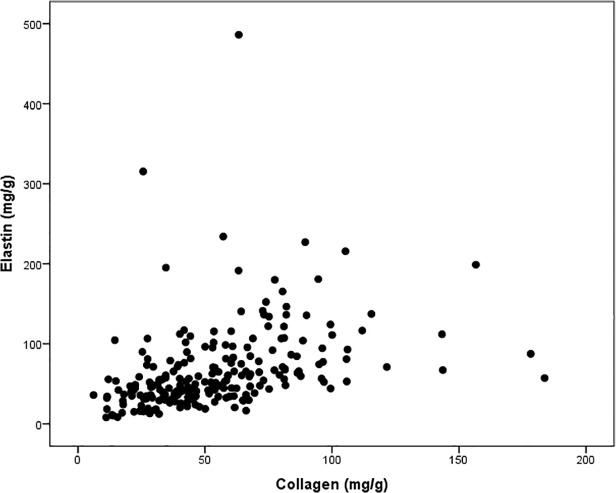
Scatter plot showing the positive correlation between elastin and collagen content (Spearman correlation r = .554, P <.0001).